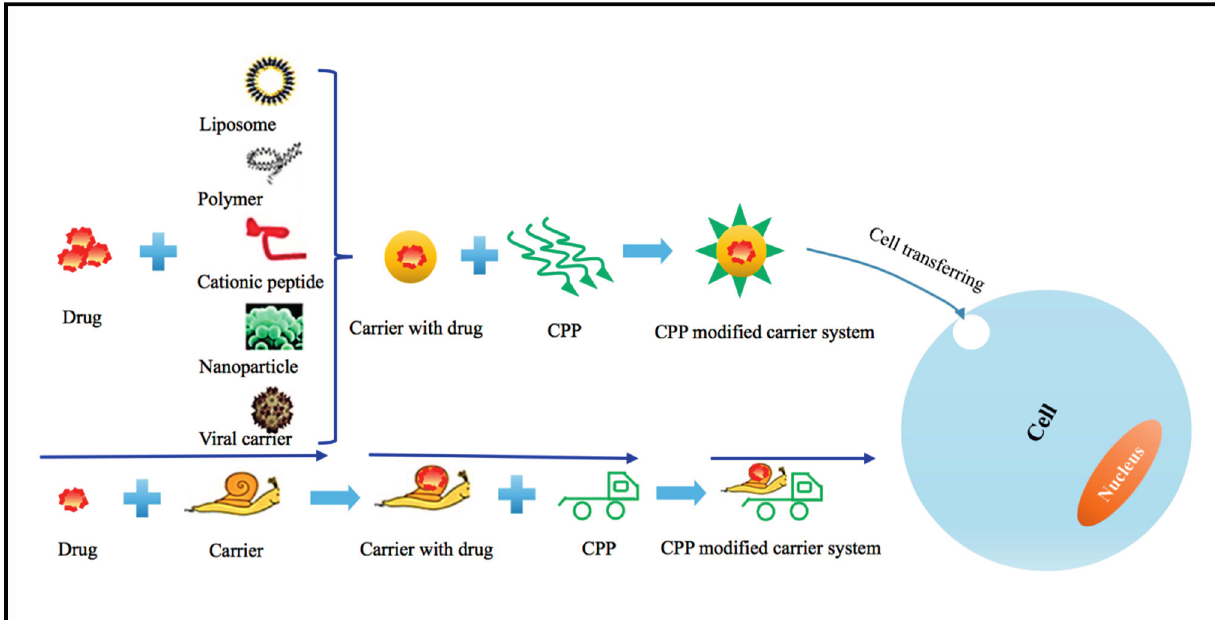
Figure 1. Enhanced drug delivery system by the combination of CPPs with other